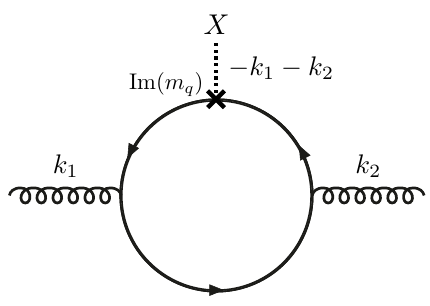
Figure 1. Feynman amplitude i Π q